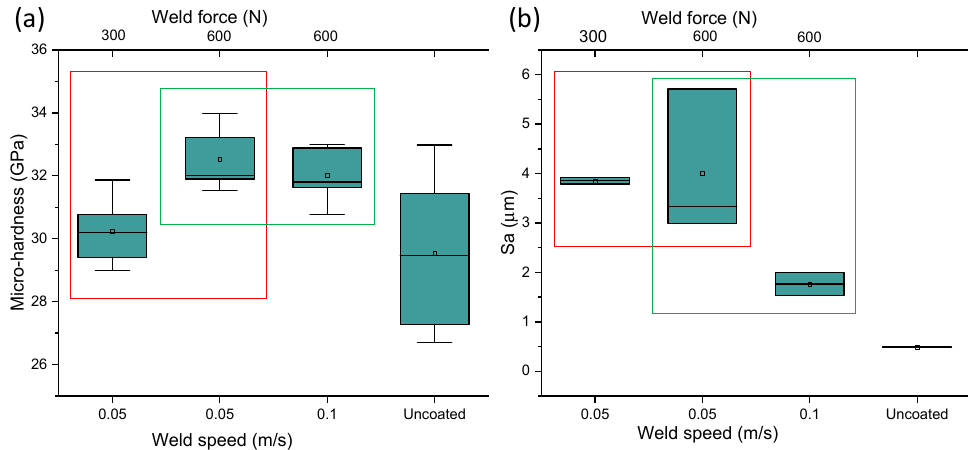
Figure 7. ( a ) Boxplot of the variation of micro-hardness as a function of weld force and weld speed, ( b ) boxplot of the effect of weld speed and weld force on the 3D surface roughness coating variation.